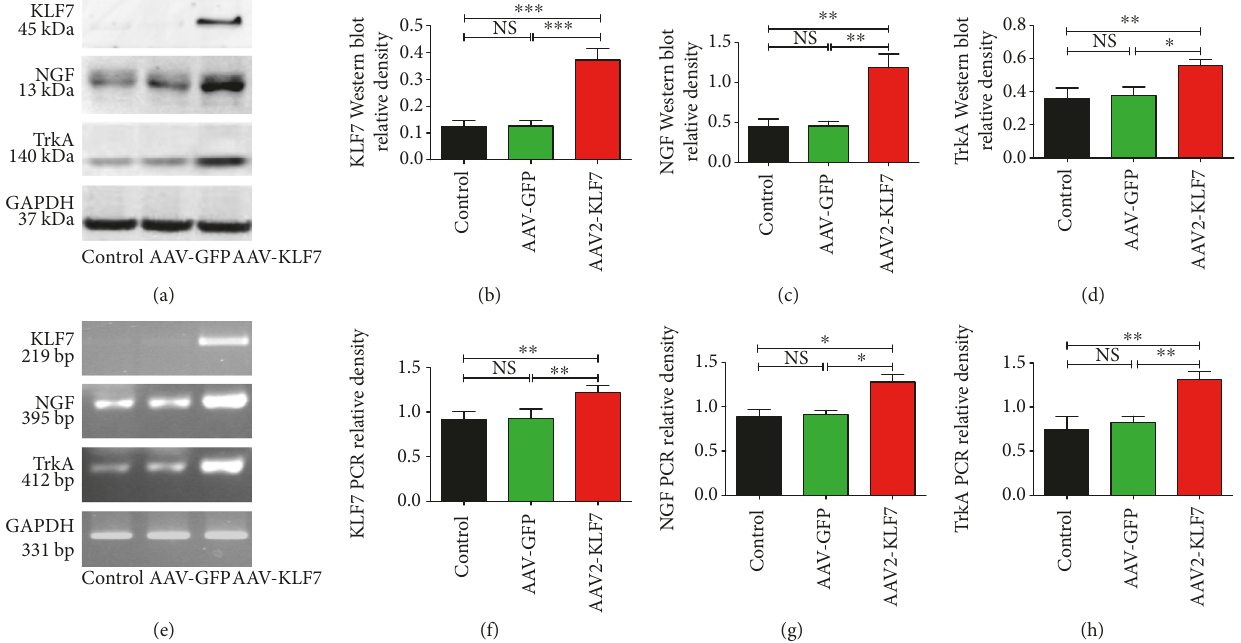
Figure 3: AAV-KLF7 signi fi cantly increased the expression of KLF7 and target proteins in vitro . (a) Representative Western blot analysis of KLF7, NGF, and TrkA expression in the cultured spinal cord neurons of the three groups is shown at 4 days in vitro (6 wells/each group). The graphs represent the relative density of KLF7 (b), NGF (c), and TrkA (d) protein. (e) Representative RT-PCR analysis of KLF7, NGF, and TrkA expression in the cultured spinal cord neurons of the three groups is shown at 4 days in vitro ( n = 6 ). The graphs represent the relative density of KLF7 (f), NGF (g), and TrkA (h) mRNA. Error bars denote SD. ∗ P < 0 05 , ∗∗ P < 0 01 , and ∗∗∗ P < 0 001 . NS: not signi fi cant. One-way ANOVA, Tukey ’ s post hoc